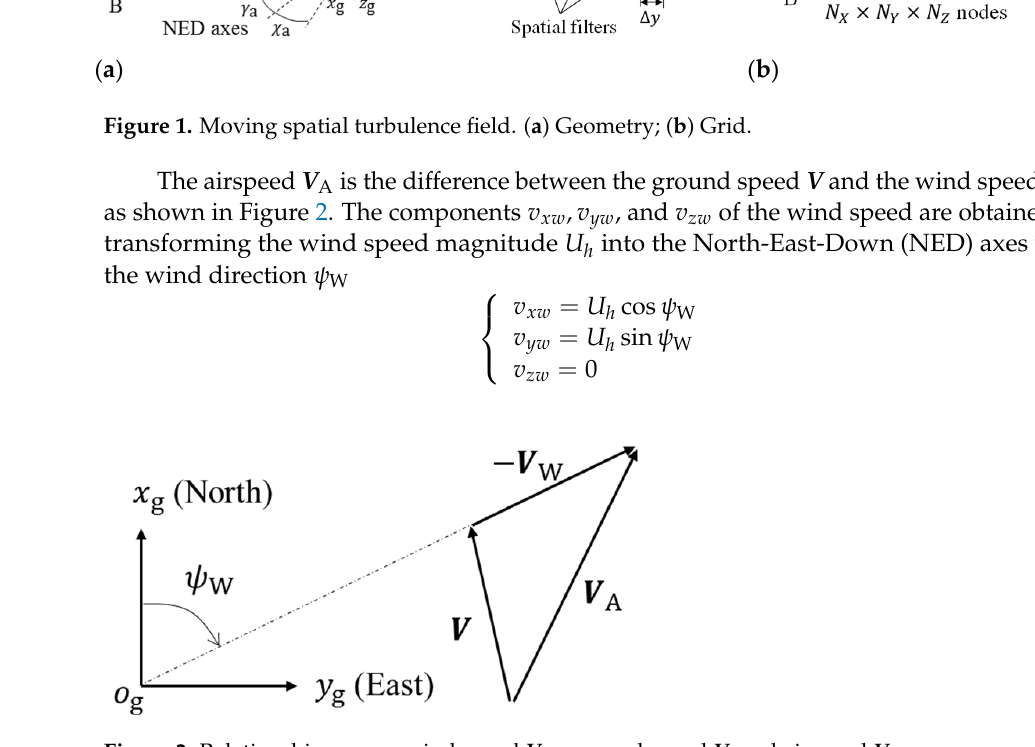
Figure 2. Relationship among wind speed 𝑽